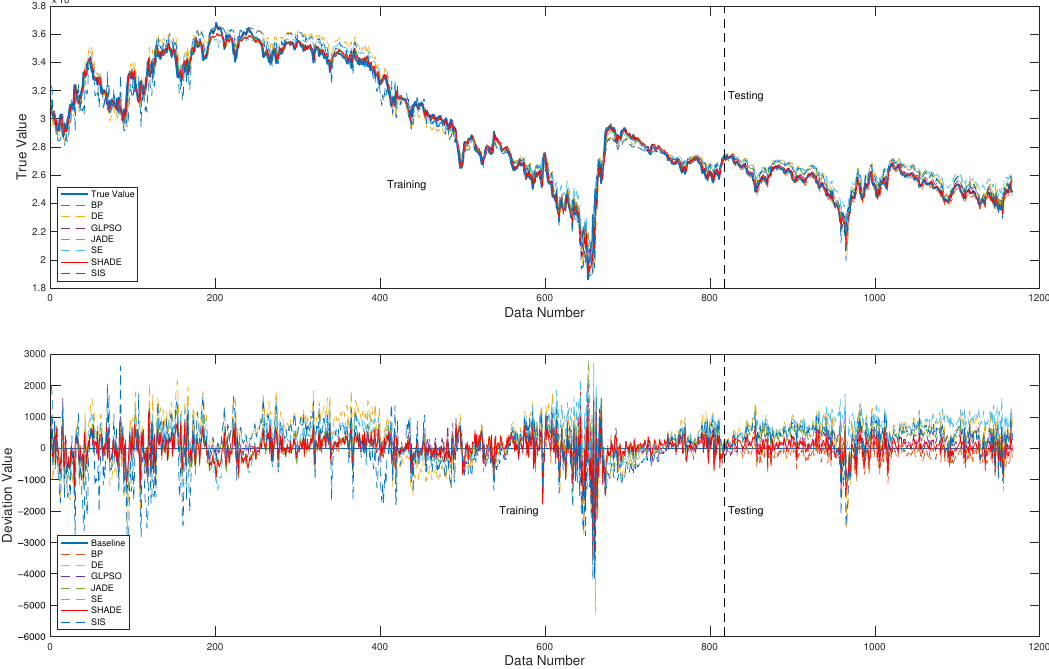
Figure 6. Prediction and deviation plots of six MHAs and BP-trained DNMs on